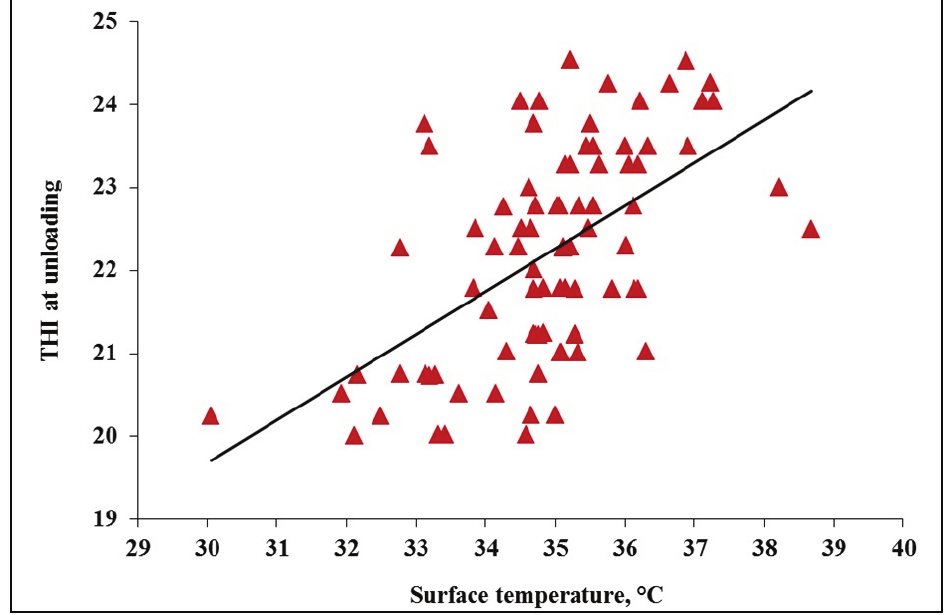
Figure 2. Experiment 1. Effects of THI at unloading on surface temperature of market weight pigs at unloading in HOT weather ((cid:2)26.7 °C; p < 0.01, R 2 =